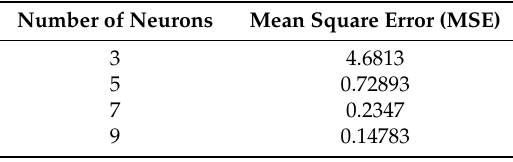
Table 2. The testing results of the number of neurons for the hidden layer in ANNs for the management Scenario